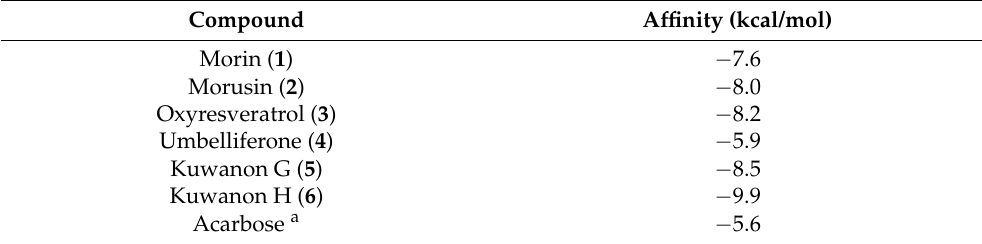
Table 9. Binding energies of active components and acarbose calculated in